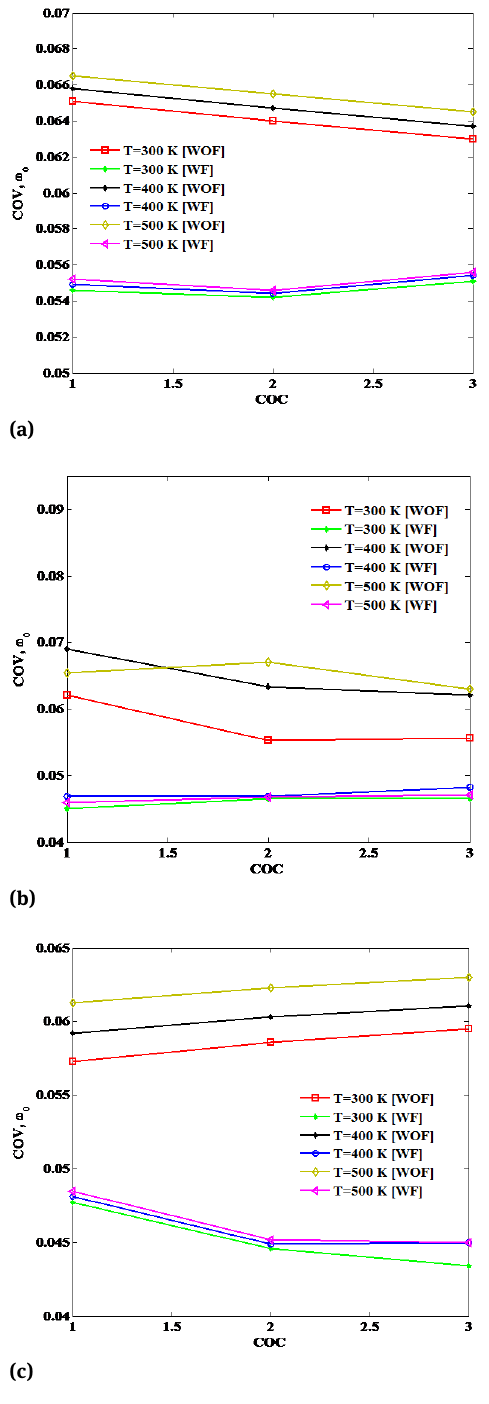
Figure 10: The effect of effect of temperatures and foundation pa- rameters with combined random variables { b i , ( i = 1 to 16) = (0.10) } on dimensionless mean and COV of nonlinear fundamental frequency of simply supported CNTRC beam using SOPT in the case of (a) UD and (b) FG-X and (c) FG- Λ of CNTRC distributed beams at a / h = 25, V * cn = 0.12 , COC = 0.10, N = 10 4